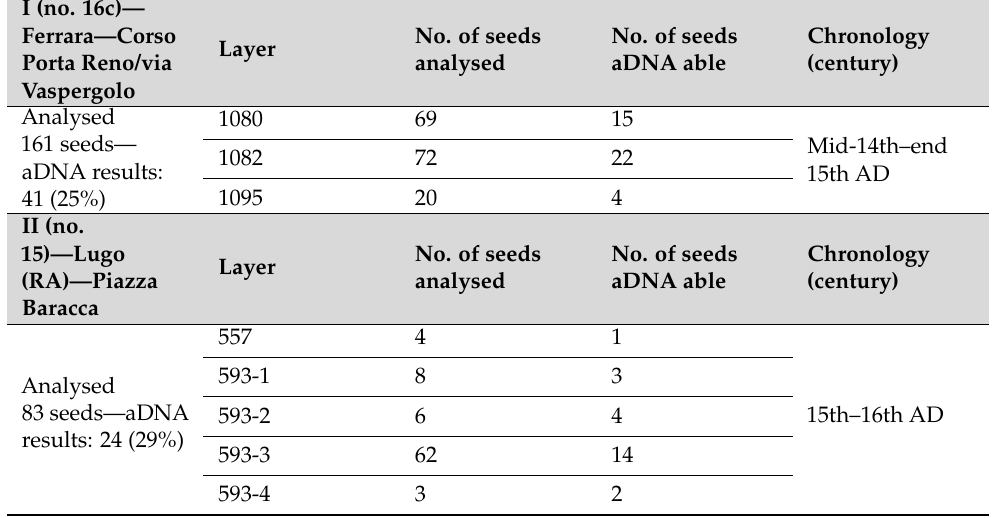
Table 6. Summary of Brassica -type seed samples used for the aDNA